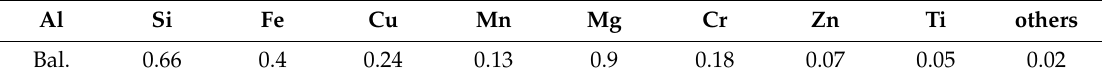
Figure 1. ( a ) Schematic diagram of free edge test and ( b ) image of a specimen after the test. Table 1. Chemical composition (wt.%) of powder used in this study. Table 2. Process parameter values for free edge test.